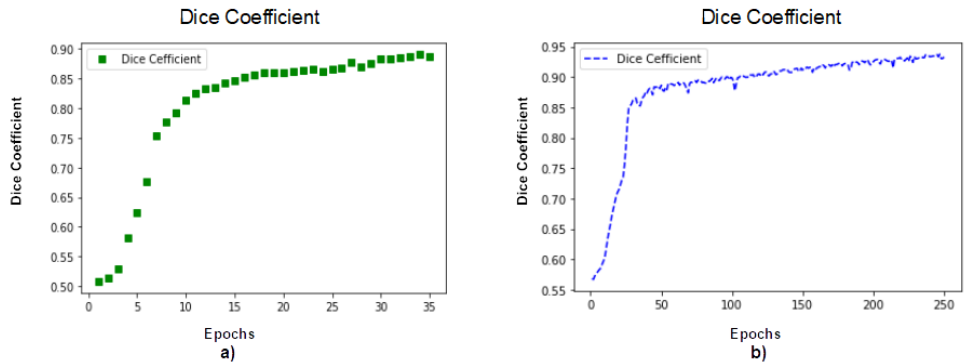
Figure 7. Dice coefficient results curves of the proposed system on the ISBI 2017 and PH2 datasets. ( a ) Dice coefficient results curve on ISBI 2017 dataset; ( b ) Dice coefficient results curve on PH2